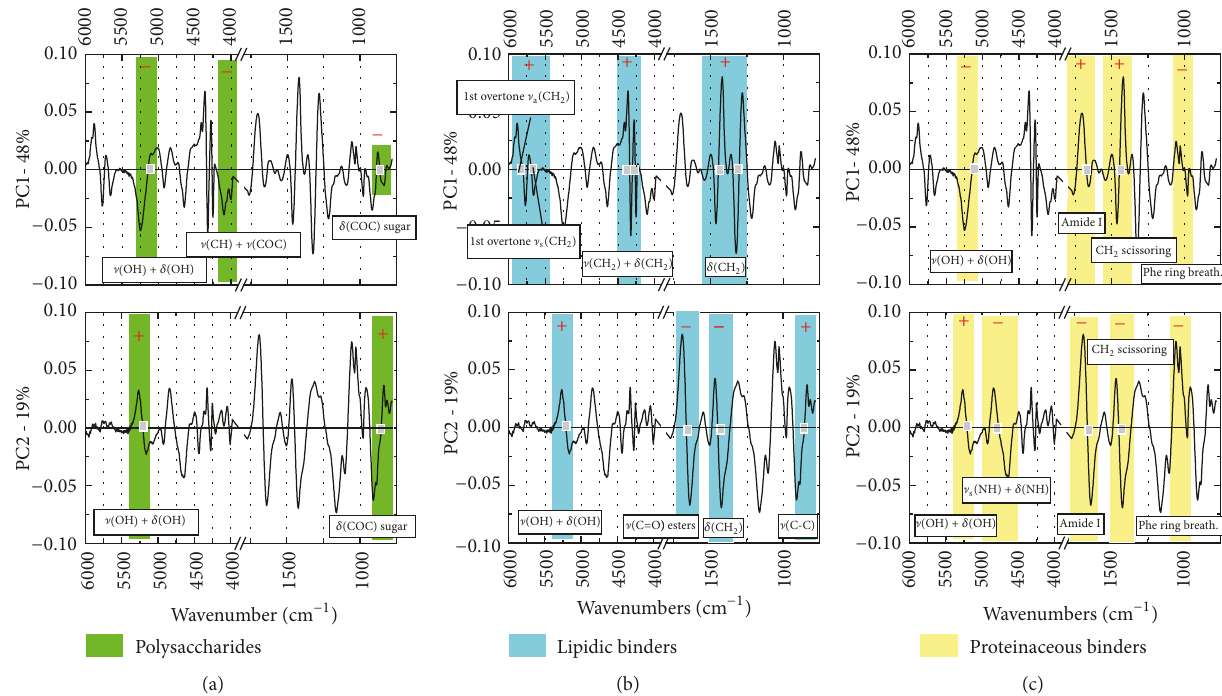
Figure 6: PCA applied to combined FT-NIR and Raman first derivative spectra, taking into account all neat binding media: score plot of PC1-PC2 (a); loading plots of PC1 and PC2, highlighting in the different panels the bands associated with different materials: polysaccharides (a), lipids (b), and proteinaceous materials